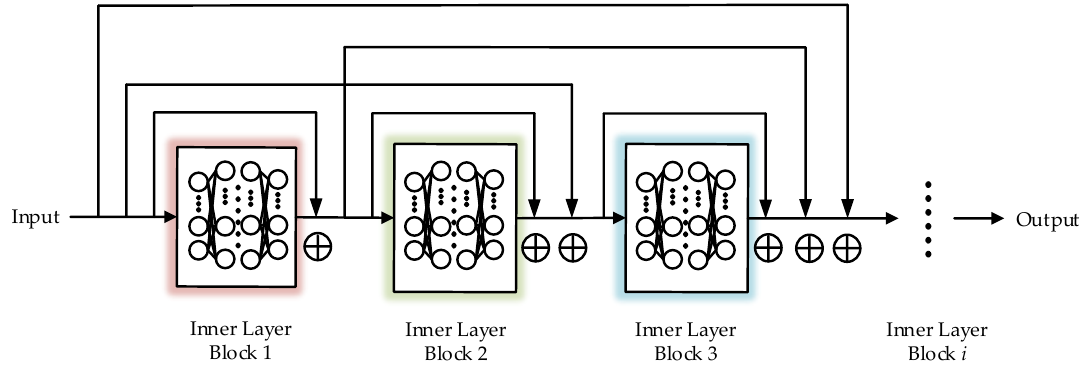
Figure 7. The structure of fully cumulative connected deep neural networks.